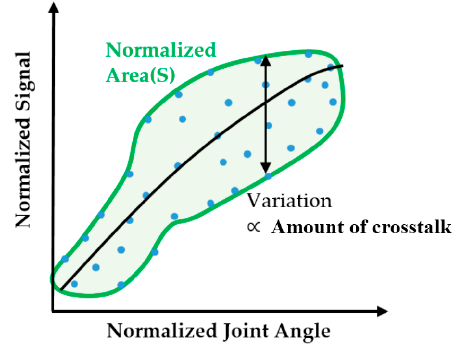
Figure 8. Deriving the magnitude of crosstalk of the CMC-joint angle sensor from a plot of the